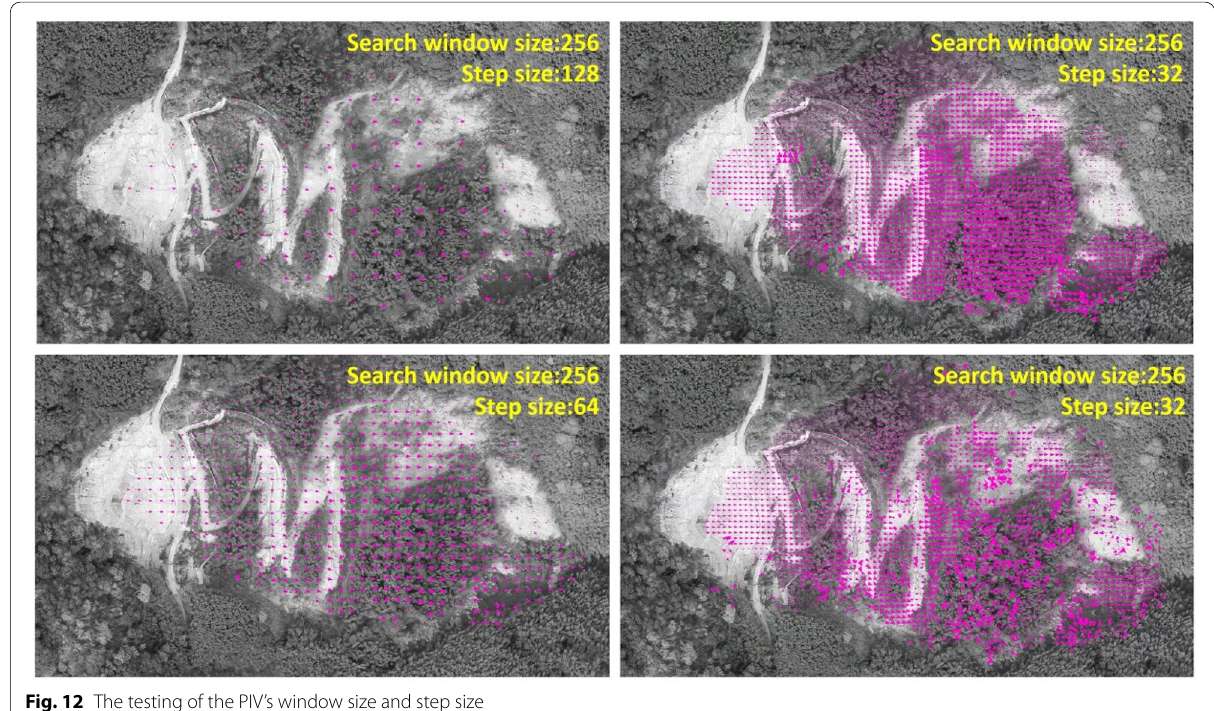
Fig. 12 The testing of the PIV’s window size and step